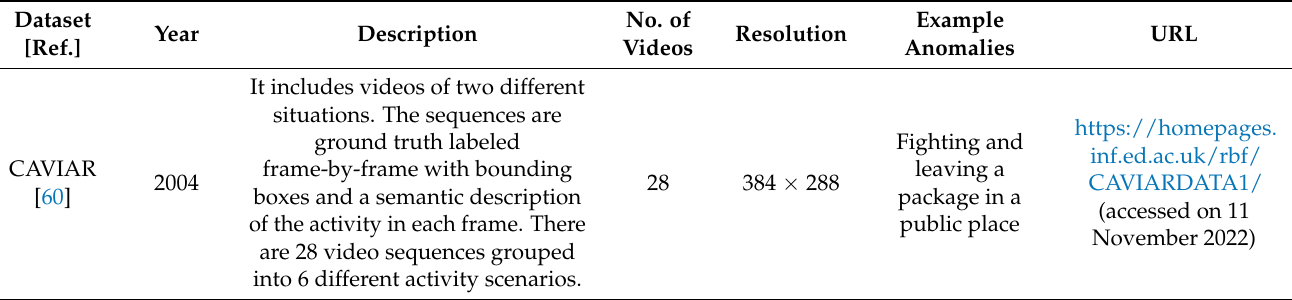
Table 2. An overview of common datasets used for